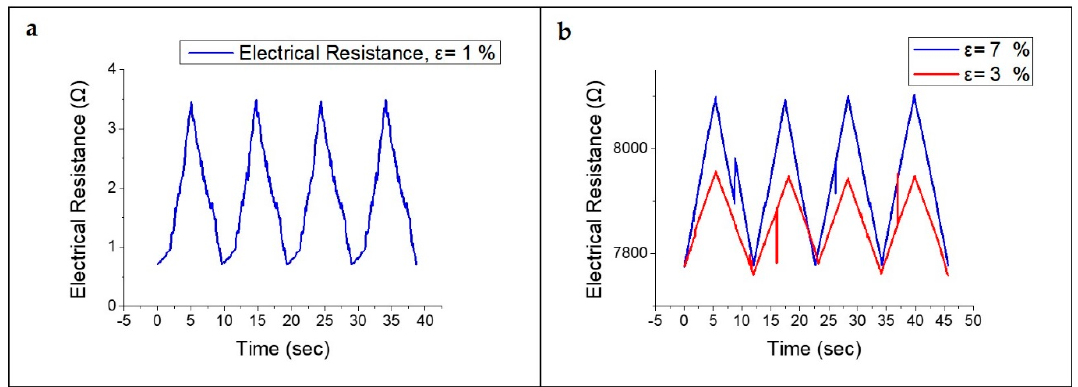
Figure 8. Response of LIG strain sensor under stretch/release cycle of ( a ) ε = 1%; ( b ) ε = 3% and 7%. Figure 9. Response of LIG strain sensor under stretch / release cycle of ( a ) ε = 1%; ( b ) ε = 3% and 7%.